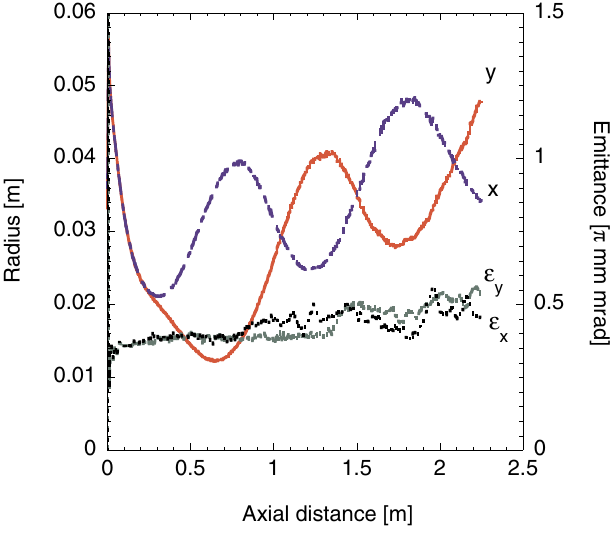
FIG. 6. (Color) Beam envelope and normalized edge emittance evolution in ESQ accelerator at the design point after modifica- tion for the second configuration.